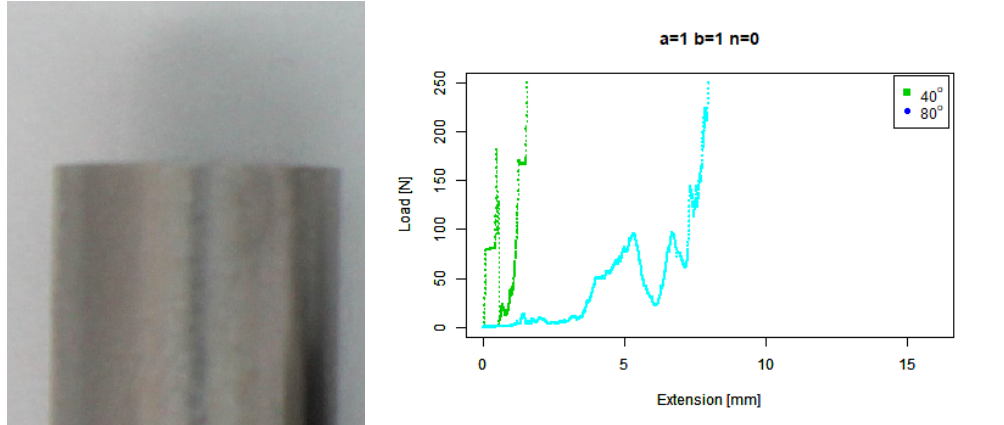
Figure 6. Flat tip. ( Left ) Tip Profile. ( Right ) Experimental characterisation.